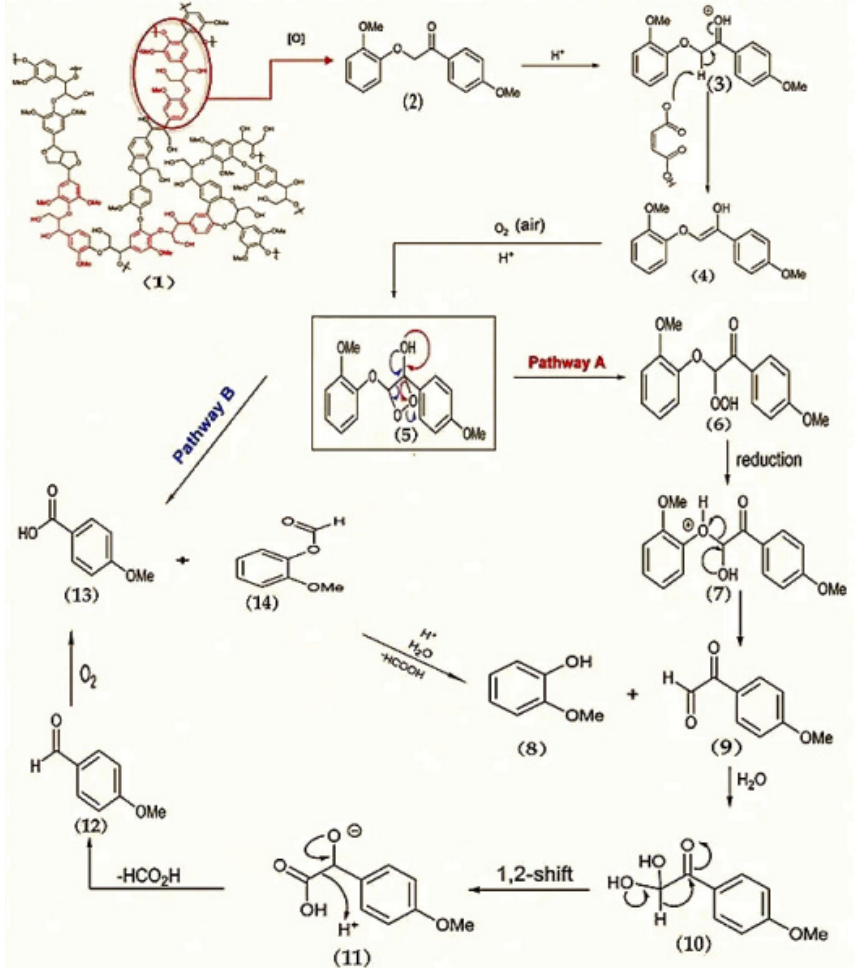
Figure 7. Proposed mechanism of CS delignification using maleic acid.